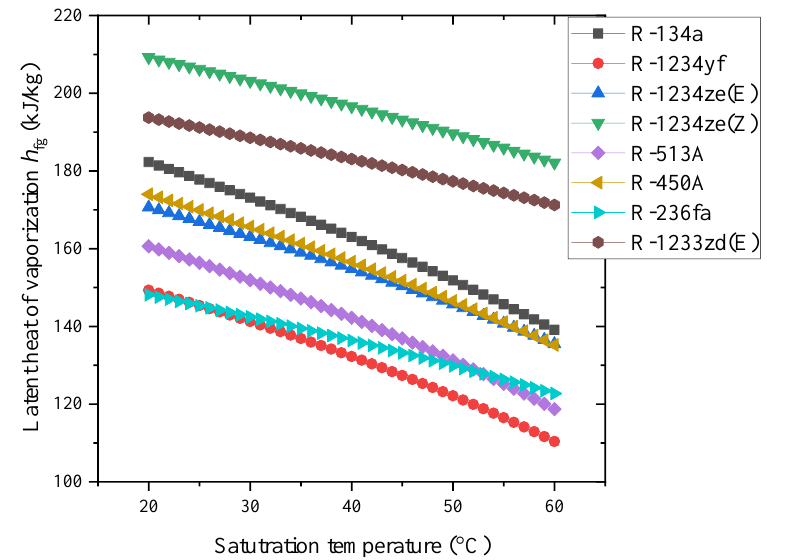
Figure 21. Saturation temperature vs. latent heat of vaporization of alternatives to R-134a [1].